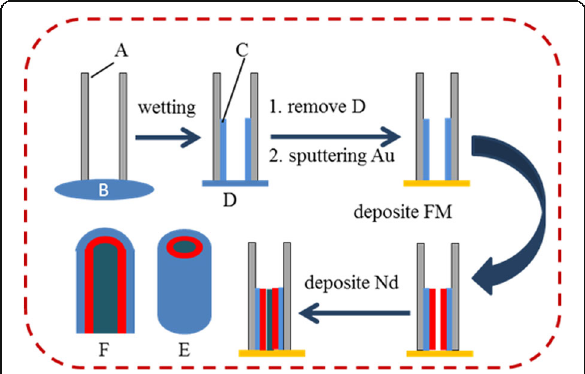
Fig. 1 Schematic diagram of preparing tri-layer nanocable: (A) AAO template, (B) polymer solution, (C) polymer nanotube, (D) polymer membrane, (E) and (F) structure and section drawings of nanocable